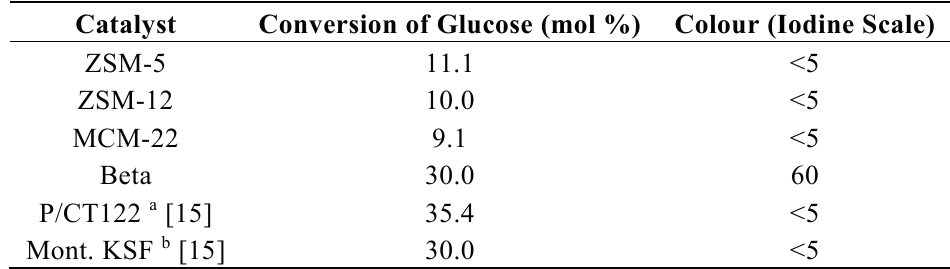
Table 2. Synthesis of perfluoroalkylglucosides over different heterogeneous catalysts at 100 °C. Reaction conditions: glucose: alcohol molar ratio = 1:10, p = 200 Torr, reaction time 5 h.